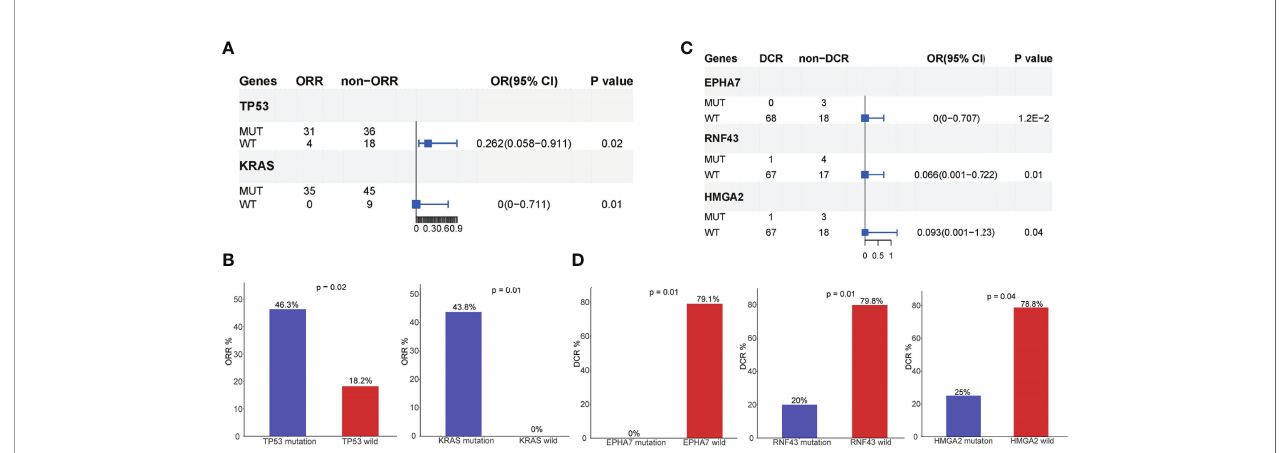
FIGURE 4 | Analysis of mutated genes associated with prognosis. (A, B) TP35 and KRAS mutations were signi fi cantly correlated to ORR of AG chemotherapy. The ORR of TP53 mutant patients is 46.3%, while the ORR of TP53 wild type patients is 18.2%.The ORR of KRAS mutant patients is 43.8%, while the ORR of KRAS wild type patients is 0%. (C, D) EPHA7, RNF43 , and HMGA2 mutations were signi fi cantly correlated to the DCR of AG chemotherapy. The DCR of EPHA7 mutant patients is 0%, while the DCR of EPHA7 wild type patients is